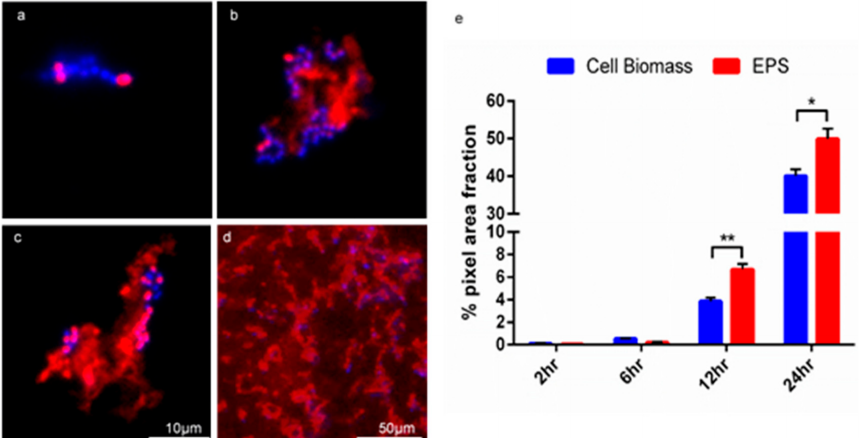
Figure 3. The GFA can be used to visualise and quantitate the biofilm development of MF04010. Biofilms were stained with Con-A (red) and Hoechst (blue) and imaged with florescence microscopy. ( a ) 100 × micrograph of 2-h biofilm growth. ( b ) 100 × micrograph of 6-h biofilm growth. ( c ) 100 × micrograph of a 12-h biofilm growth. ( d ) 40 × micrograph of a 24-h biofilm growth. Scale bar for 100 × micrographs ( a – c ) represents 10 microns. ( e ) Graph of quantification of cell biomass staining versus EPS staining of MF04010. The Hoechst and Con-A micrographs from the biofilm growth of MF04010 were imported into ImageJ. Micrographs were converted to 8-bit images and the % grey pixel areas were computed as per the ImageJ analyse-measure function. At the 12-h time-point the p value between cell biomass and EPS was * 0.0001. At the 24-h time-point the p value between cell biomass and EPS was **